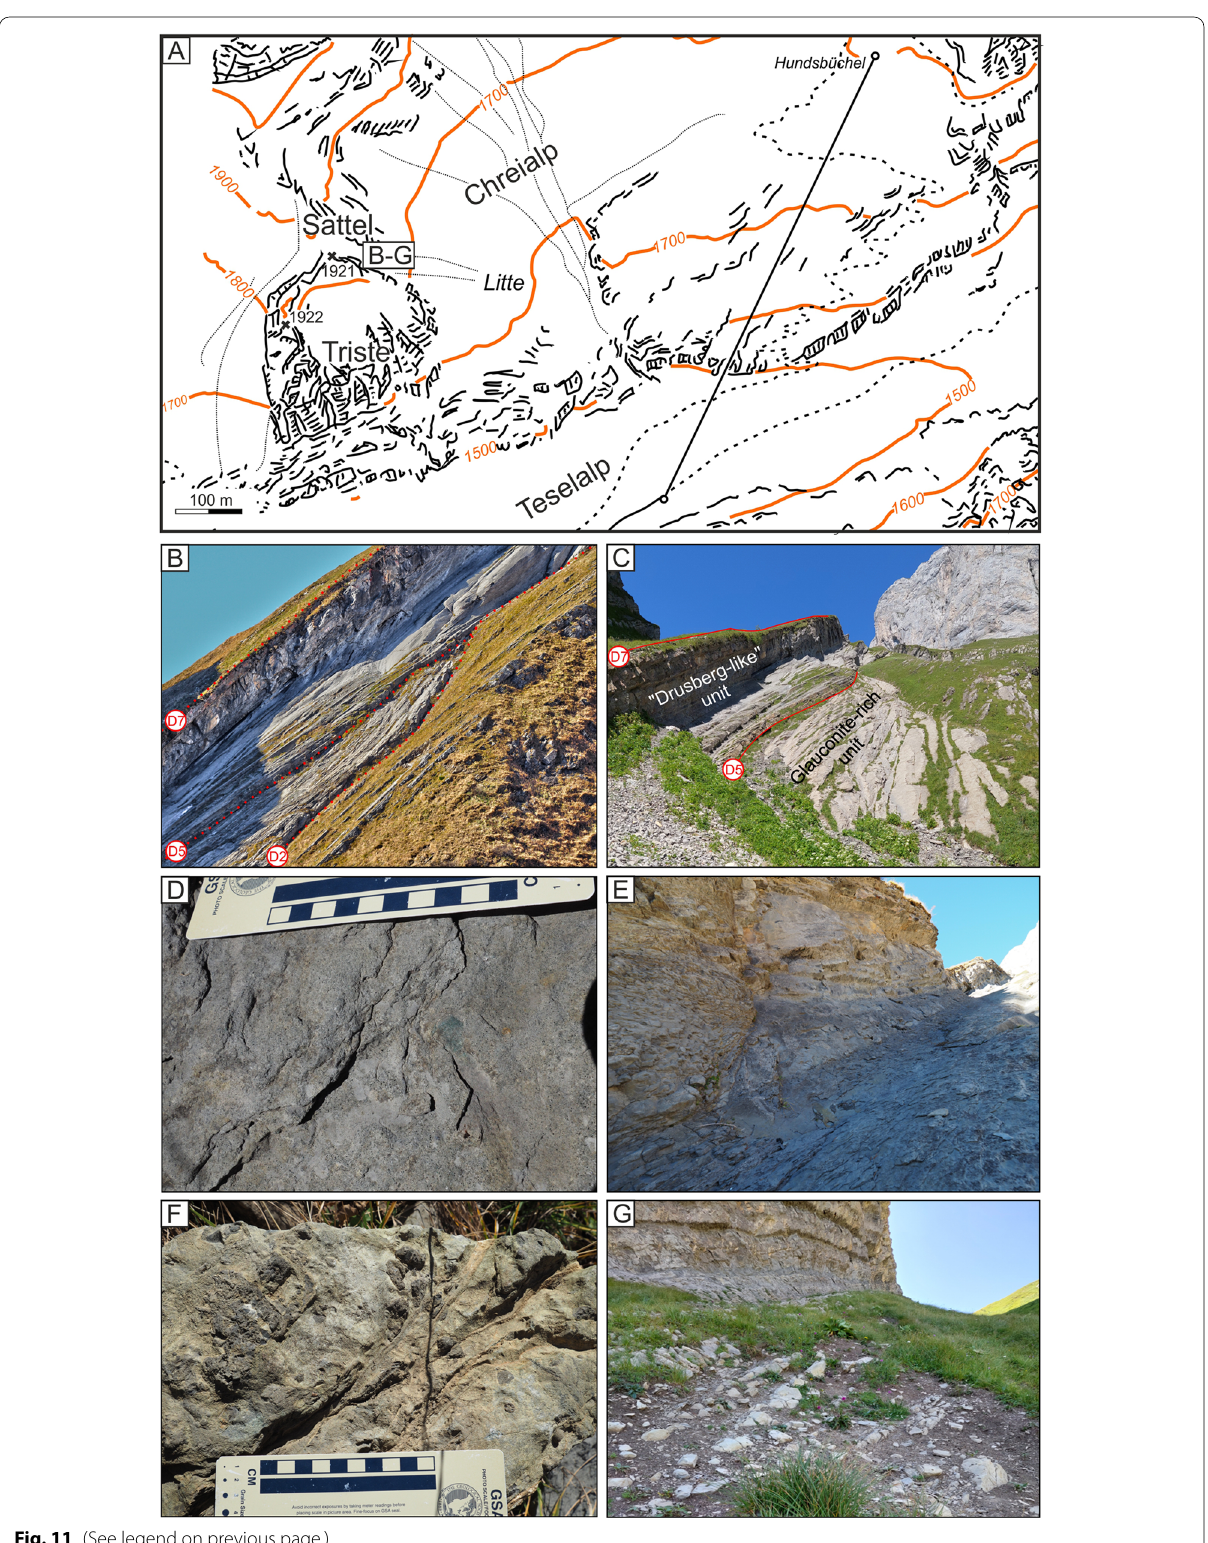
Fig. 11 (See legend on previous